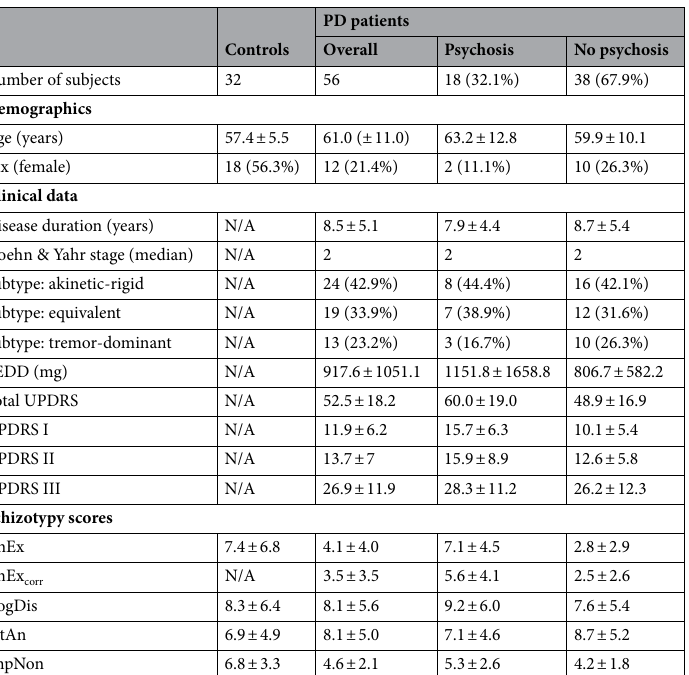
Table 1. Demographics and clinical data. If not otherwise indicated mean ± SD or n (%) of